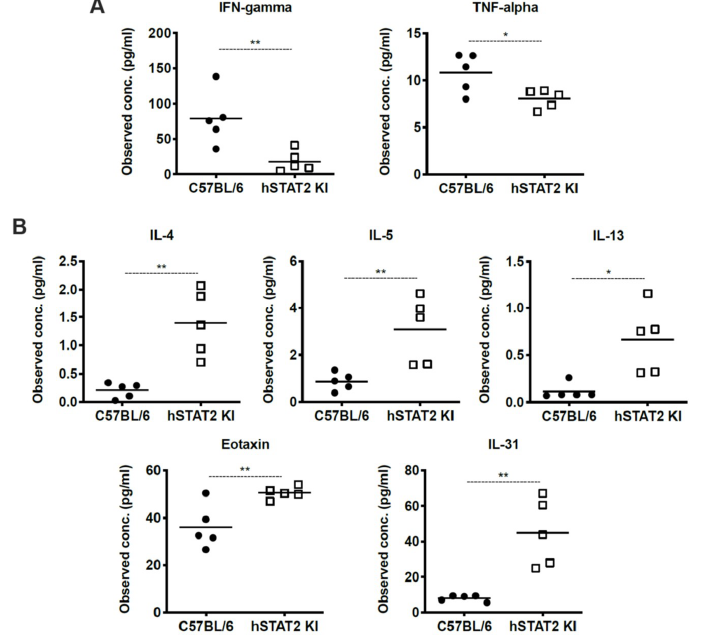
Figure 8. HMPV-infected hSTAT2 KI mice adopt a Th2-skewed cytokine profile. hSTAT2 KI mice and C57BL / 6 mice were intratracheally inoculated with HMPV at 5 × 10 6 pfu / mL. At day five